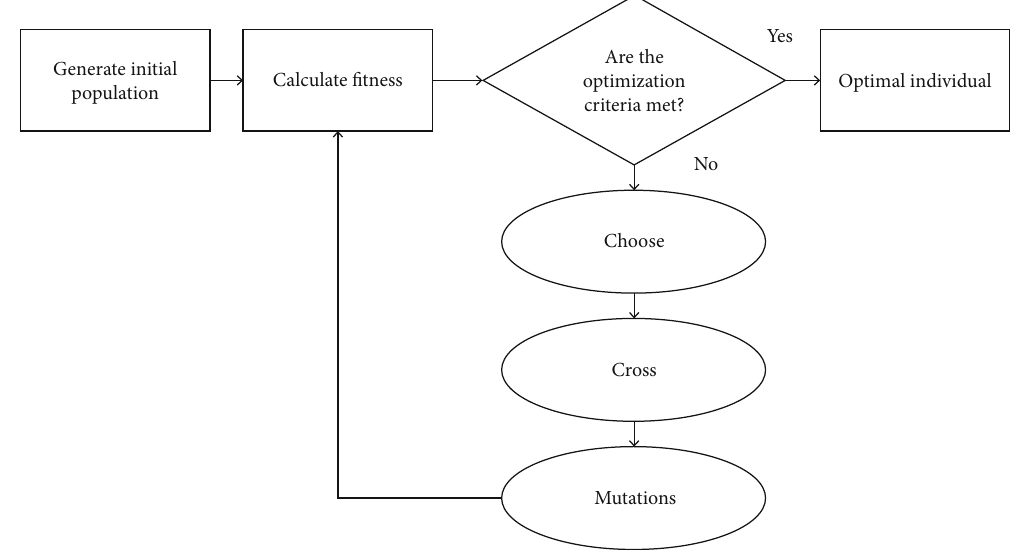
Figure 1: The basic operation fl ow chart of the